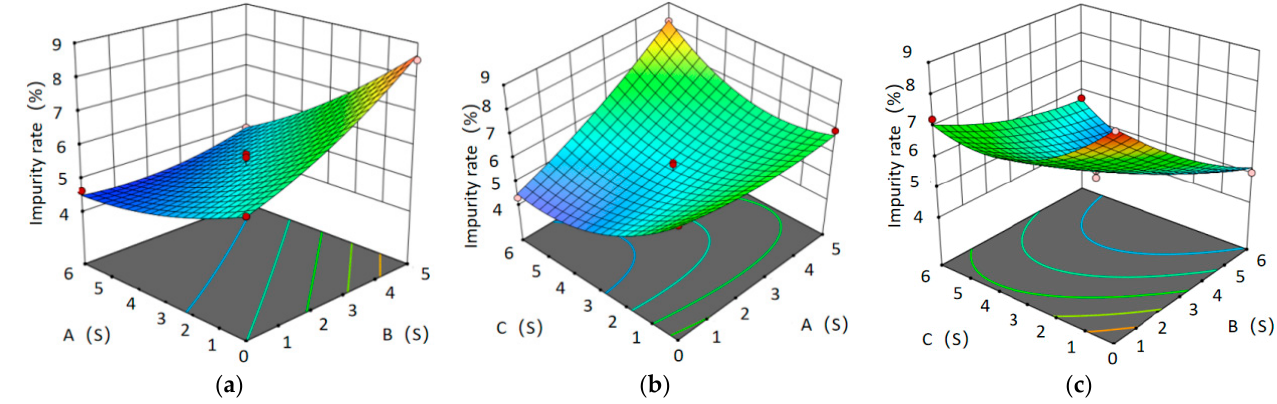
Figure 18. Influence of test factors on the impurity rate of Lan tea materials in the No. 2 lower-level material outlet. ( a ) Effect of No. 3 and No. 5 baffle on impurity rate; ( b ) Effect of No. 3 and No. 6 baffle on impurity rate; ( c ) Effect of No. 5 and No. 6 baffle on impurity rate. When the test material is pan-fried green tea, due to the different physical properties